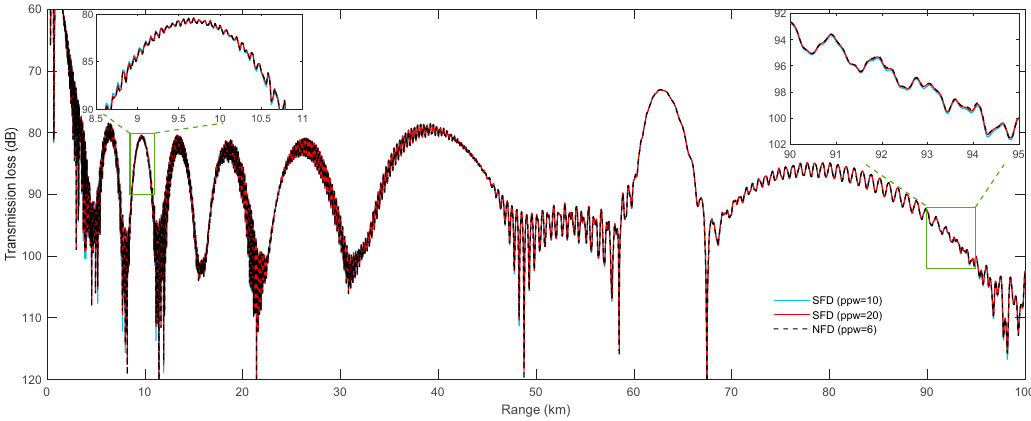
Figure 9. TL curves at the depth of the sound source in the Munk waveguide case. Figures 10 and 11 show the two TL contours in the Munk waveguide case using the NFD with PPW = 6 and the SFD with PPW = 20, respectively. Due to the large range and depth of the sound field, the grid step size in the depth direction has little effect on the sound field visualization, and the characteristics of these two sound fields are identical.